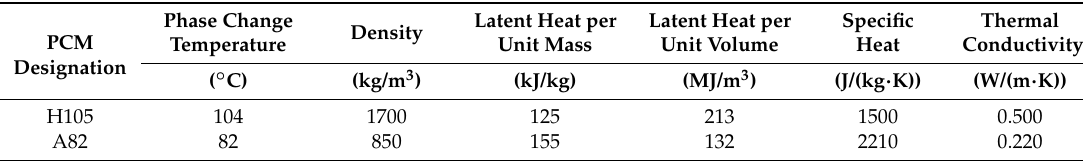
Table 1. Thermal properties of the tested PCM’s.